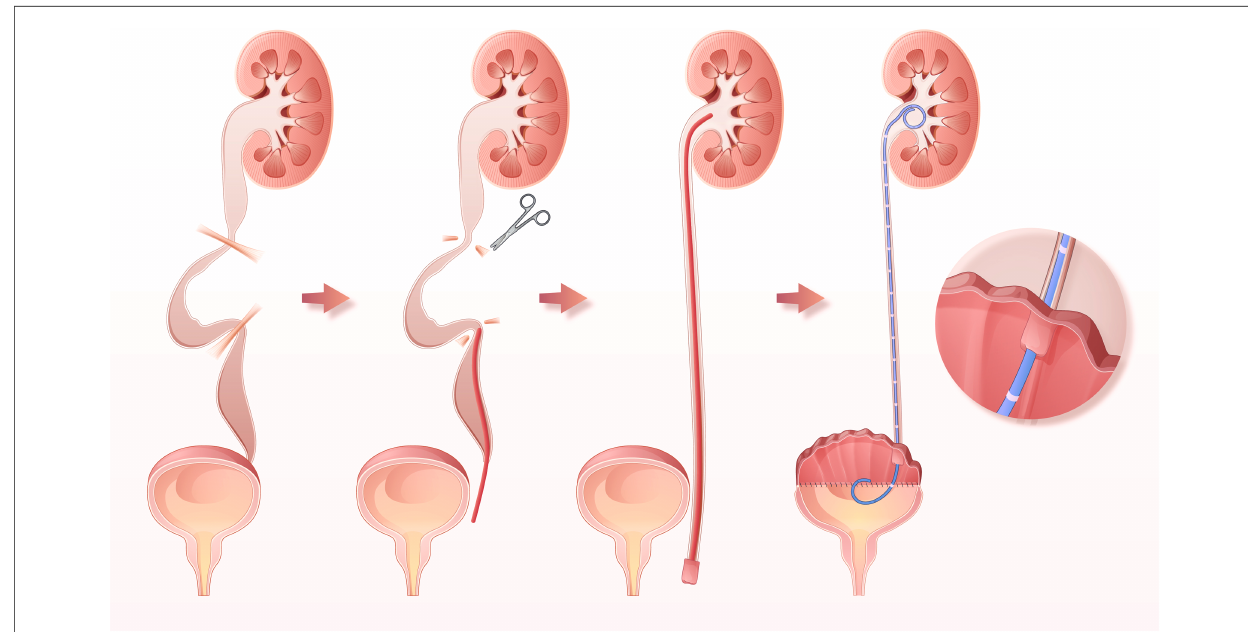
FIGURE 1 Illustrations of AUEC. ( A ) UUTD characterized as external compression, stricture, and angulation of the ureter, with proximal ureter tortuosity and dilation above the obstruction. ( B ) Releasing of the tortuosity knots or constricting fi brous bands, straightening, shorting, and tailoring of the ureter. ( C ) Straightening, shorting, and tailoring of the ureter. ( C ) The successful mobilization of the ureter, indicated by the presence of abundant urine drainage from pelvis. ( D ) Intravesical mobilization of the terminal ureter, with subsequent reimplantation on the neobladder through a new hiatus and Kock nipple